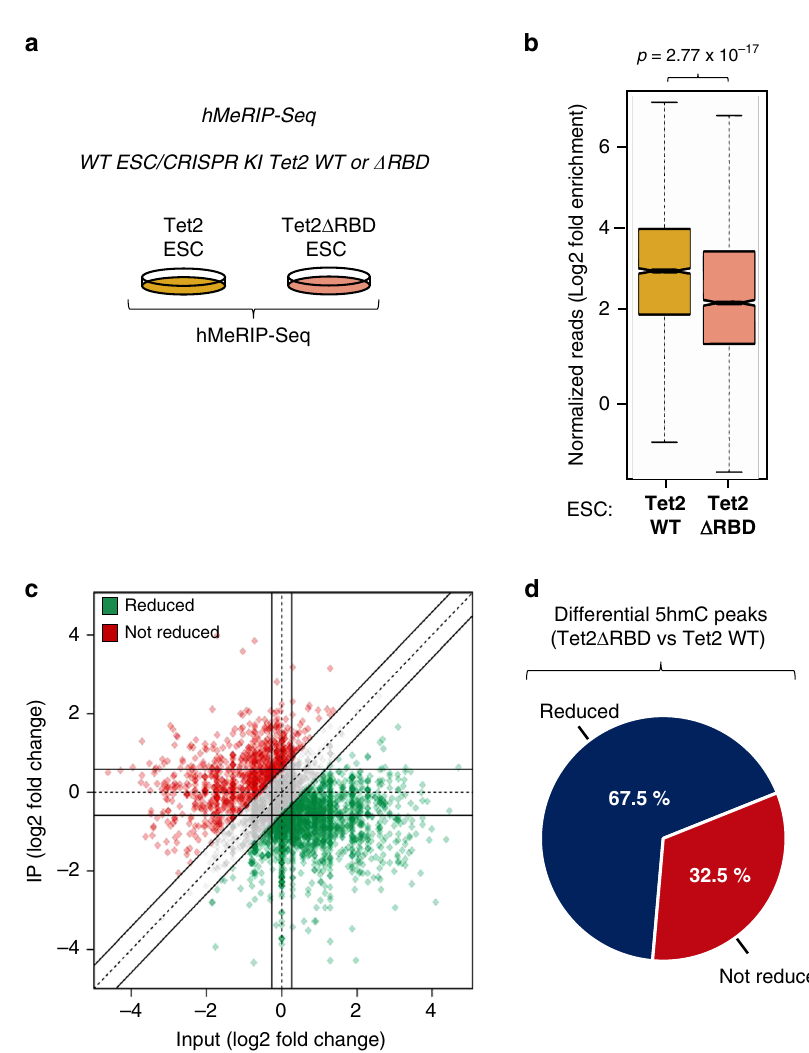
Fig. 4 Tet2-mediated RNA hydroxymethylation depends, at least in part, on Tet2 RBD. a Scheme illustrating the hMeRIP experimental design using CRISPR Tet2WT KI and CRISPR Δ RBD KI ESCs. b Box plot showing a signi fi cant difference in the normalized number of 5hmC reads between Tet2WT and Tet2 Δ RBD ESCs ( n = 3 independent experiments, one-tailed Student ’ s t -test). In the box plot, the boxes represent the interquartile range of the records, and the lines across the boxes indicate the median value of the records. The whiskers indicate the highest and lowest values among the records that are no more than 1.5 times greater than the interquartile range. The range between notches represents the 95% con fi dence interval. c Quadrant chart showing differential 5hmC peaks in CRISPR Tet2WT KI vs CRISPR Tet2 Δ RBD KI ESCs. d Pie chart highlighting the percentage of transcripts whose 5hmC level is reduced in Tet2 Δ RBD- compared to Tet2WT-producing